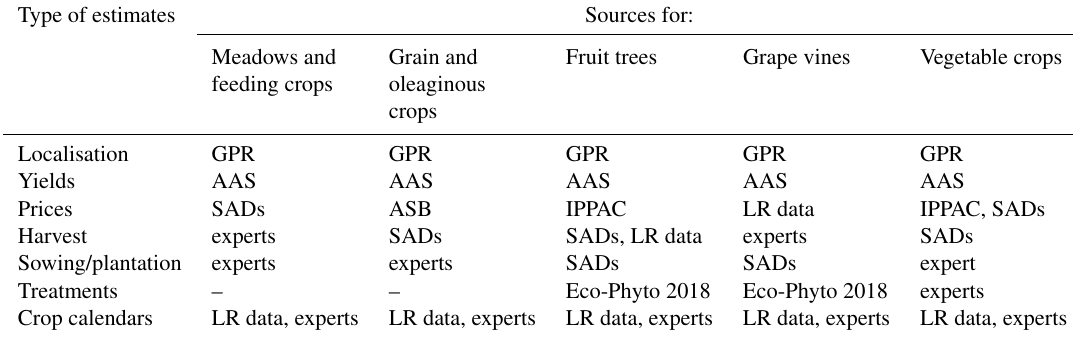
Table 9. Data sources. Type of estimates Sources for: